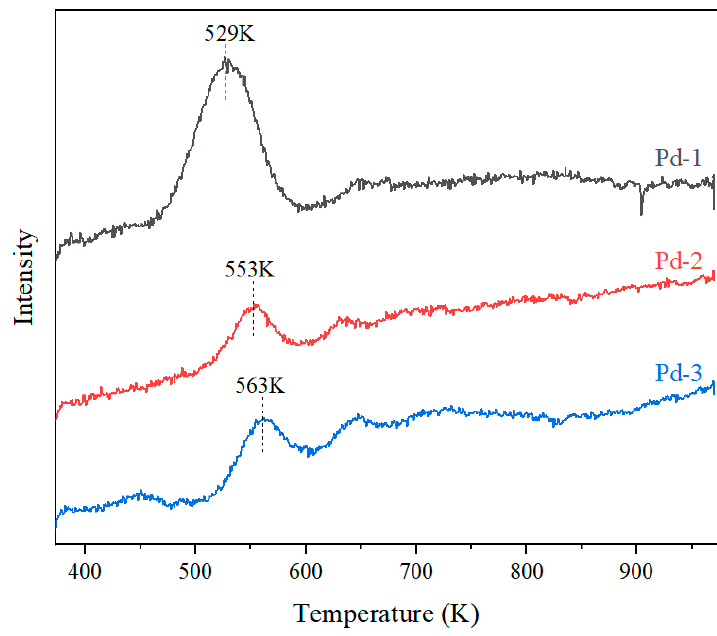
Figure 5. H 2 -TPR diagram of Pd-1, Pd-2 and Pd-3.